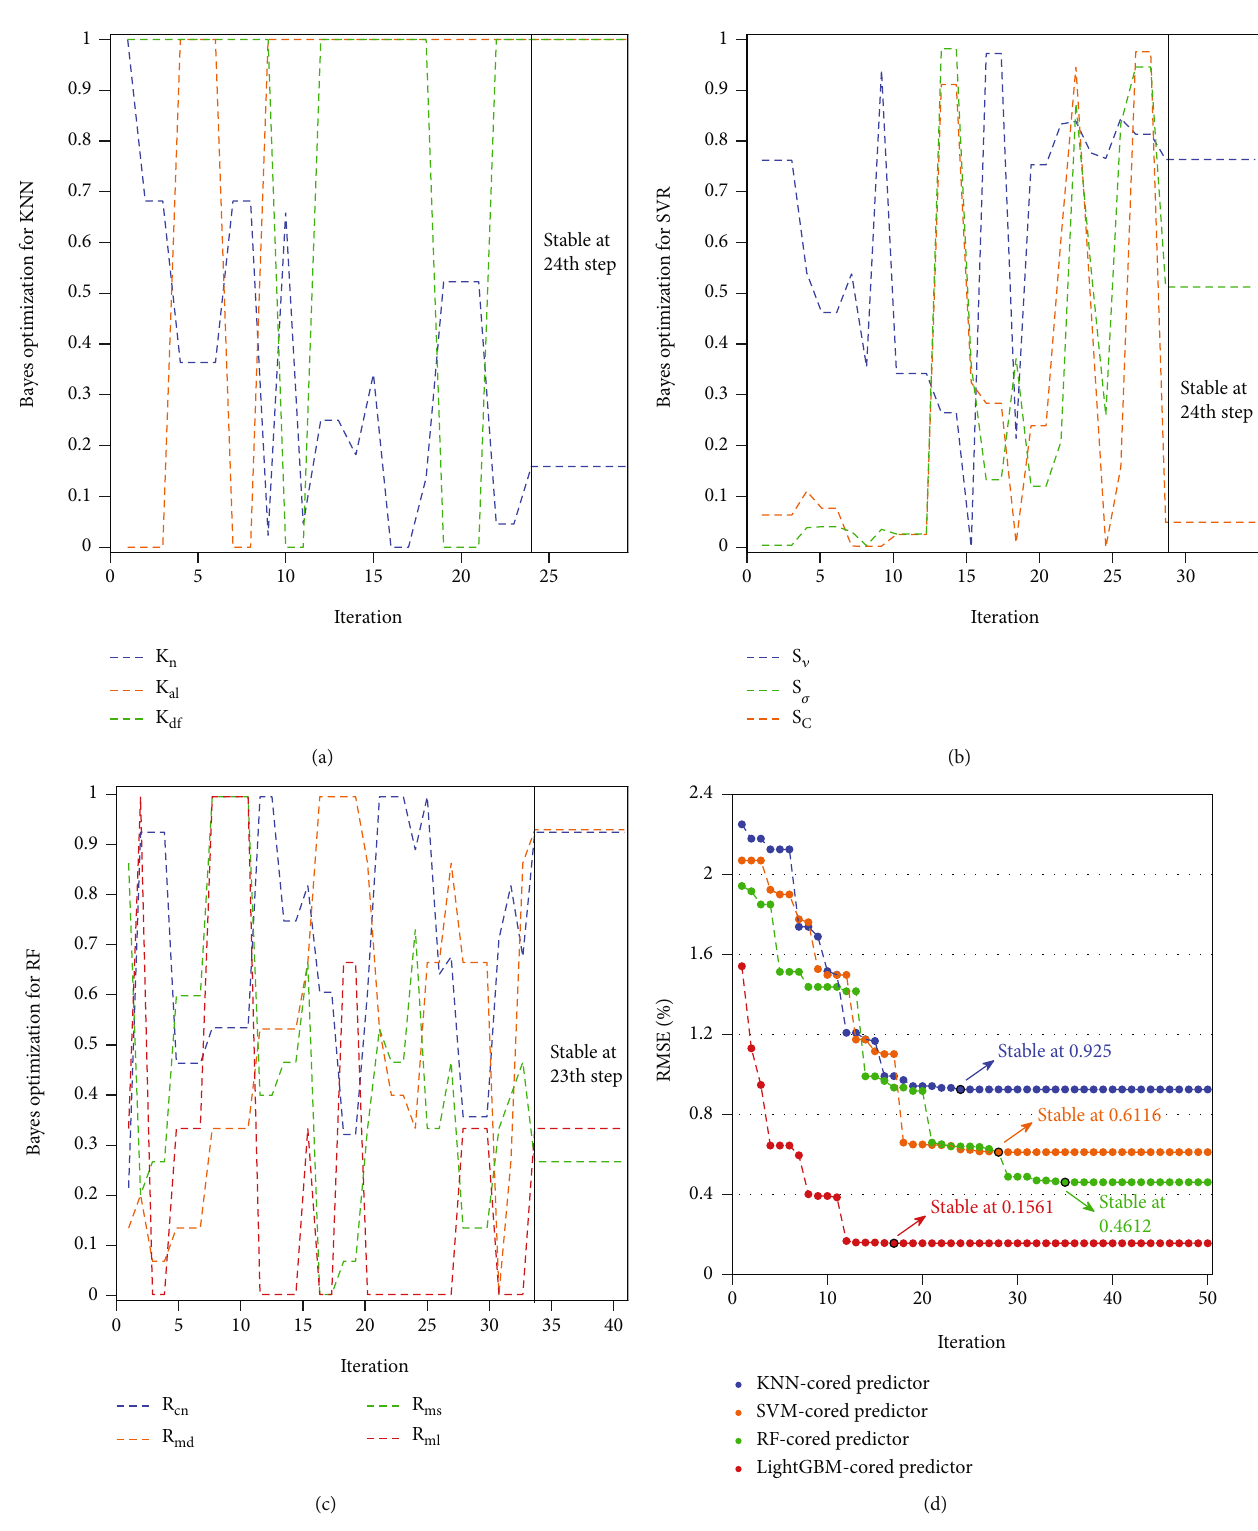
Figure 8: Variations of hyperparameters of KNN (a), SVR (b), and RF (c) implemented by Bayesian optimization and downtrends of RMSE of porosity values obtained by four validated predictors during the whole iteration (d). KNN =k-nearest neighbors; SVR =support vector regression; RF =random forest; LightGBM=light gradient boosting machine; RMSE =root-mean-square